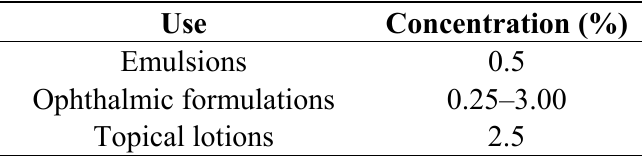
Table 3. Uses of polyvinyl alcohol